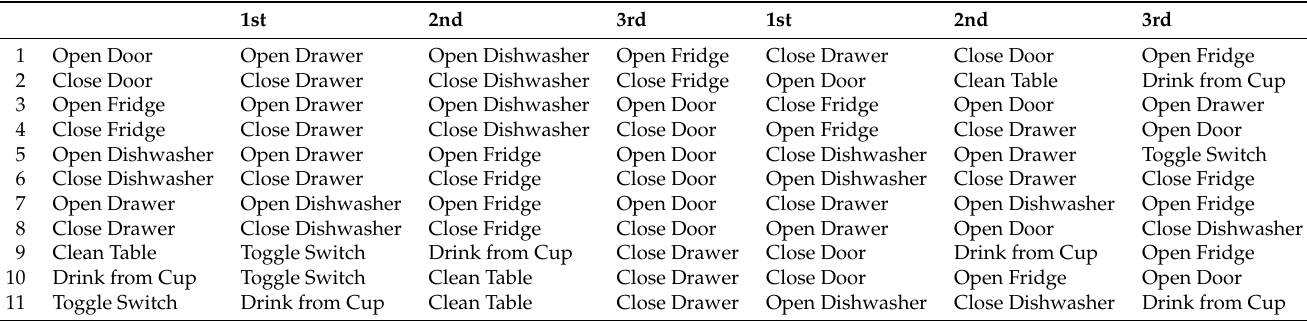
Table A8. Top 3 nearest words in the attribute space (left) and the embedding space (right) for the OPP dataset.